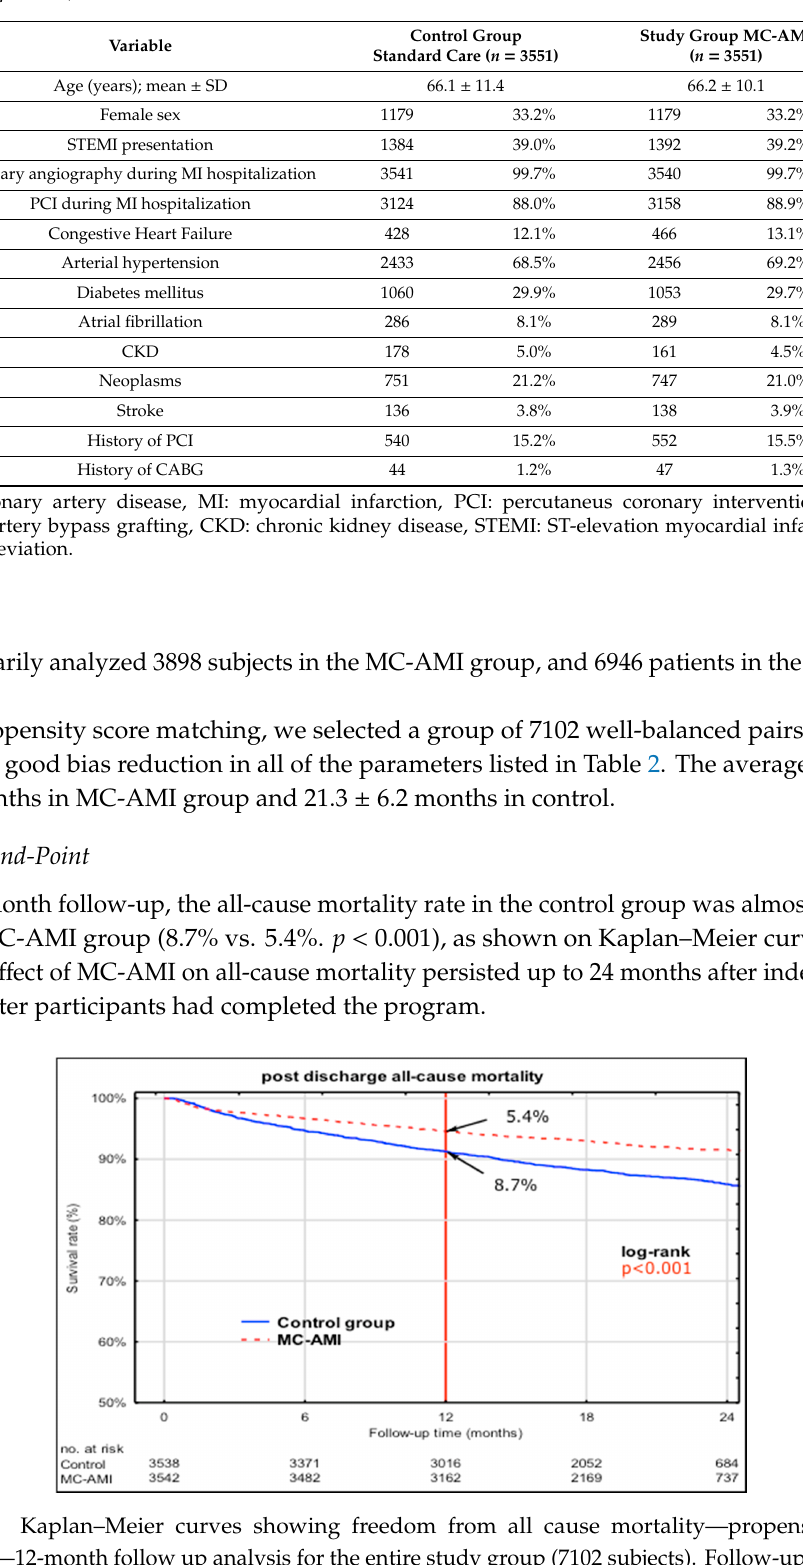
Table 2. Characteristics of two study groups after propensity score matching; all variables listed matched ( p = NS).